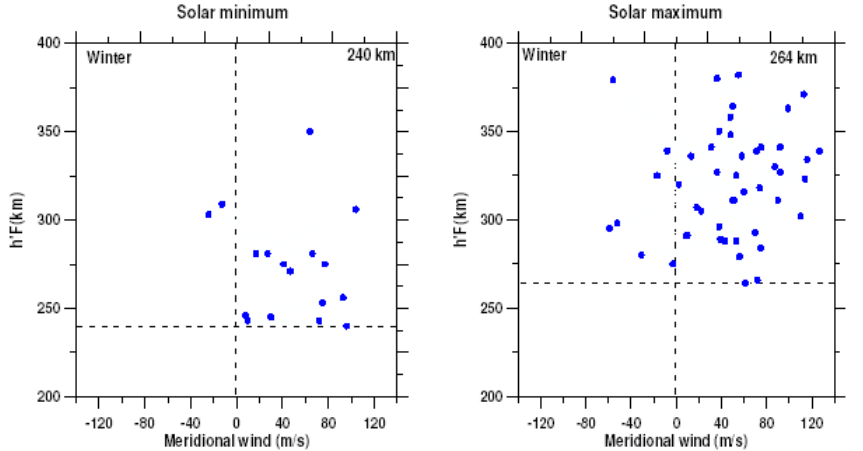
Fig. 2. Scatter plot of meridional wind and h 0 F prior to triggering of ESF for winter solstice of solar minimum (left panel) and solar maximum (right panel).